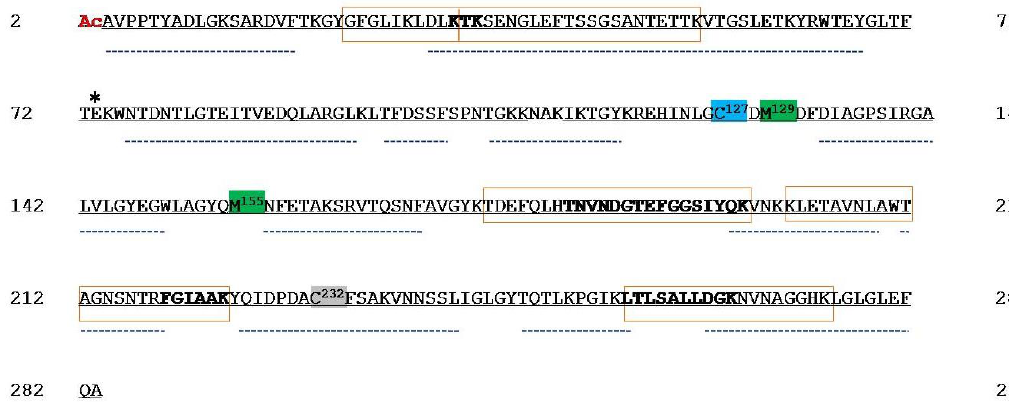
Figure 1. Sequence coverage map of hVDAC1 obtained by tryptic and chymotryptic digestion. The gray solid line indicates the sequence that was obtained with tryptic peptides; dotted lines the sequence obtained with chymotryptic peptides. The carboxyamidomethylated cysteine residue is highlighted in grey, the totally oxidized cysteine residue is highlighted in light blue and the partially oxidized methionine residues are highlighted in green. The acetyl group linked to the N-terminal alanine is shown in red. Unique tryptic peptides originated by missed-cleavages were used to distinguish and cover sequences shared by isoforms: they are indicated in the boxes. Sequences shared by more isoforms are reported in bold. Numbering of the sequence considered the starting methionine residue, actually deleted during protein maturation. Aspartic acid residue 73 shared by hVDAC1 and 2 is marked by an asterisk.